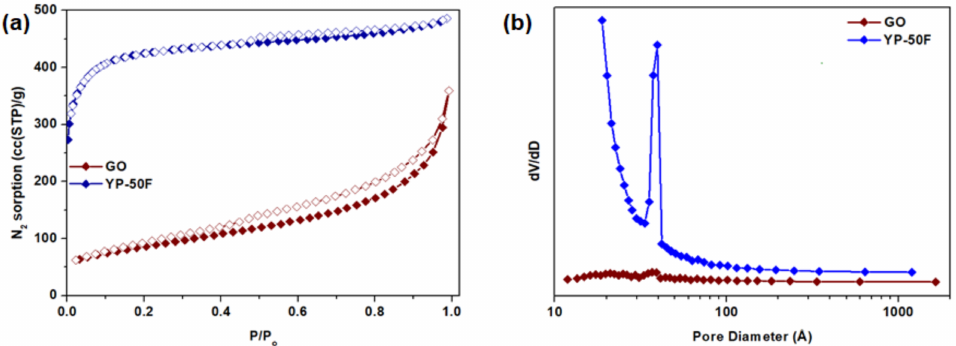
Figure 3. ( a ) N 2 physisorption isotherms and ( b ) pore size distribution of GO and YP-50F at 77